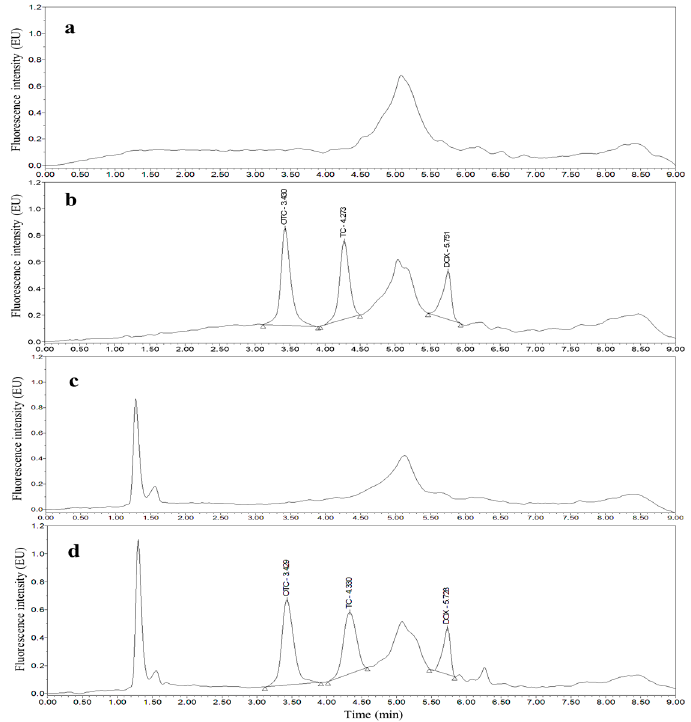
Figure 2. Chromatograms of the mobile phase ( a ), 50 μ g/kg CIP and 25 μ g/kg ENR standards ( b ), blank blended whole chicken egg ( c ) and blank blended whole chicken egg spiked with 50 μ g/kg CIP and 25 μ g/kg ENR standards ( d ) from channel B.